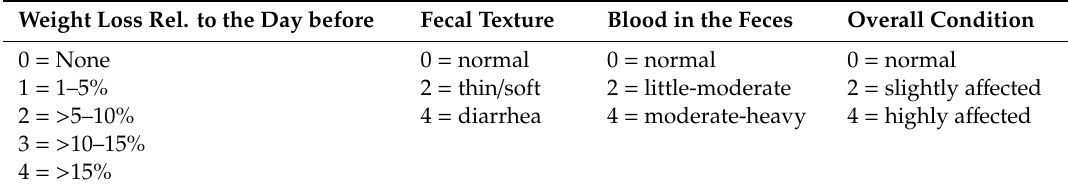
Table 1. Criteria for monitoring the health and wellbeing of the